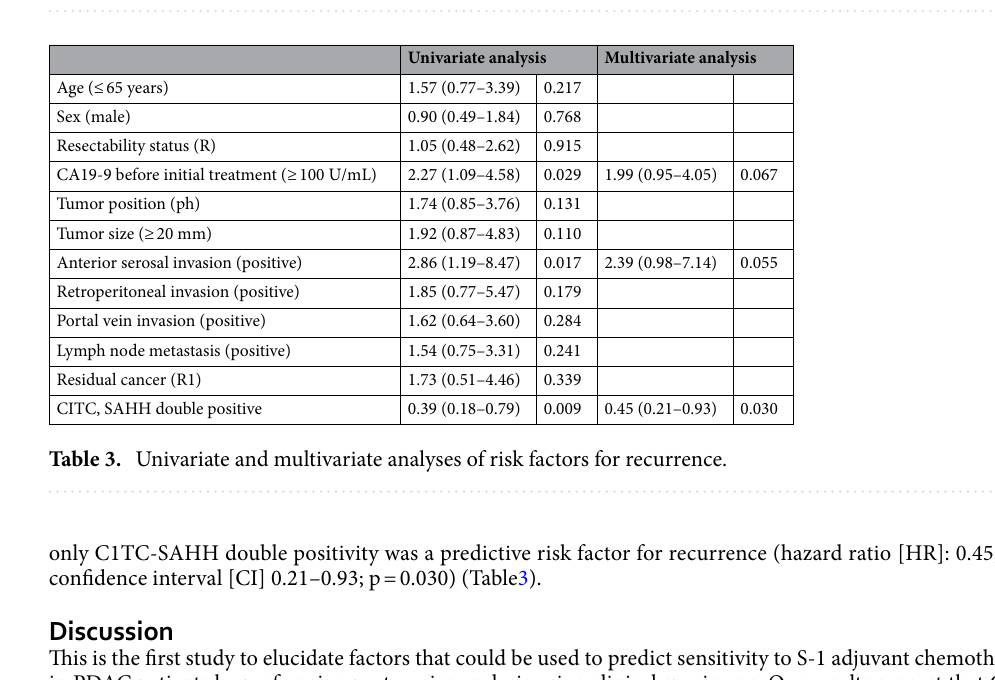
Figure 3. Recurrence free survival after combining C1TC and SAHH. There were 23 cases of both C1TC and SAHH showed positive expression, 8 cases showed both negative expressions, 8 cases showed only SAHH positive and 8 cases of C1TC positive respectively. Double positive group showed a significant improvement of RFS compared to No adjuvant group. On the other hands, when C1TC and/or SAHH was negative, there was no significant difference compared with no adjuvant group. When C1TC and/or SAHH negative cases was combined into one group and compared with double positive or No adjuvant group, RFS was dramatically worse compared with double positive group and almost similar with No adjuvant group.